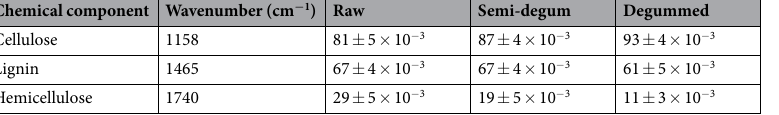
As shown in Fig. 2A, although it was mostly covered by a thin layer of lignin and/or hemicellulose, cellulose was a major component in the 2- µ m thick surface layer of the raw kenaf fiber bundle. The green and yellow areas indicate a thicker covering layer of lignin and/or hemicellulose, while the red and pink areas show the locations with a thinner, or even no, covering layer. This image demonstrates that the distributions of the components are heterogeneous on the kenaf fiber bundle. After the semi-degumming (Fig. 2B) and alkali degumming (Fig. 2C), the pink and red areas expanded significantly, indicating that the lignin and/or hemicellulose were removed by the degumming process and more and more cellulose was exposed on the surface of the fiber bundle. The results are consistent with the SEM images. As listed in Table 2, the average absorption strengths of cellulose for raw kenaf, semi-degummed kenaf and degummed kenaf are 0.081, 0.087 and 0.093, respectively, confirming the trend of the change during the degumming process. By choosing the wavenumber of 1465 cm − 1 , the infrared microspectral images of lignin distribution were obtained (Fig. 3). A slight decrease of the lignin content, especially after the alkali degumming, was observed. The average absorption strength was changed from 0.067 to 0.061 after the second step of degumming as shown in Table 2. The images suggest that the effects of the two degumming steps on lignin removal were different. In the first step (steam explosion), the lignin was broken down to smaller particles but only a small part of lignin was